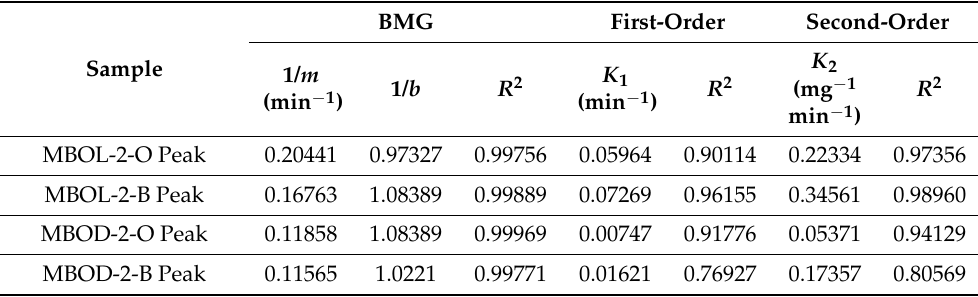
Table 3. Extracted kinetic parameters for the photodegradation of the orange peak (O) and the blue peak (B) in the mixture of MB/MO binary